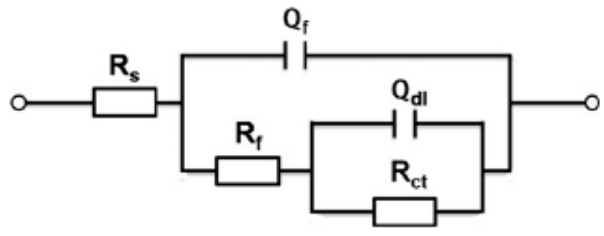
Figure 7. Equivalent circuit applied to simulate the electrochemical impedance spectroscopy results for reinforcement steel.